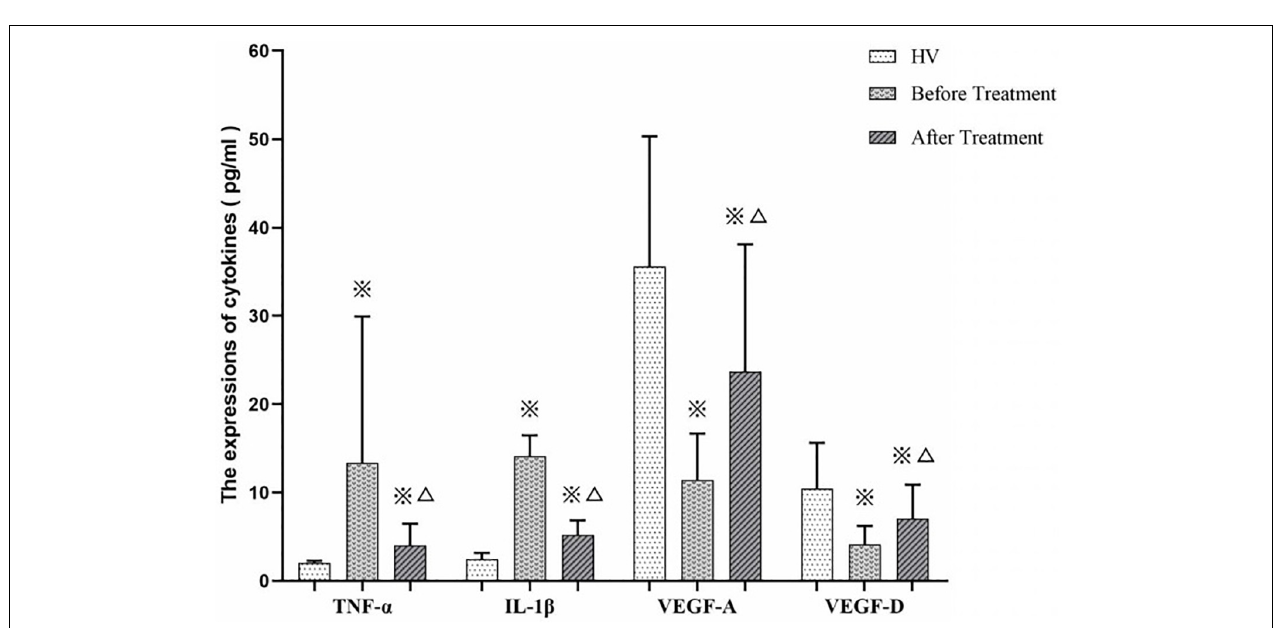
FIGURE 11 | The expressions of TNF- α , IL- β , VEGF-A, and VEGF-D in ITP patients and HV.